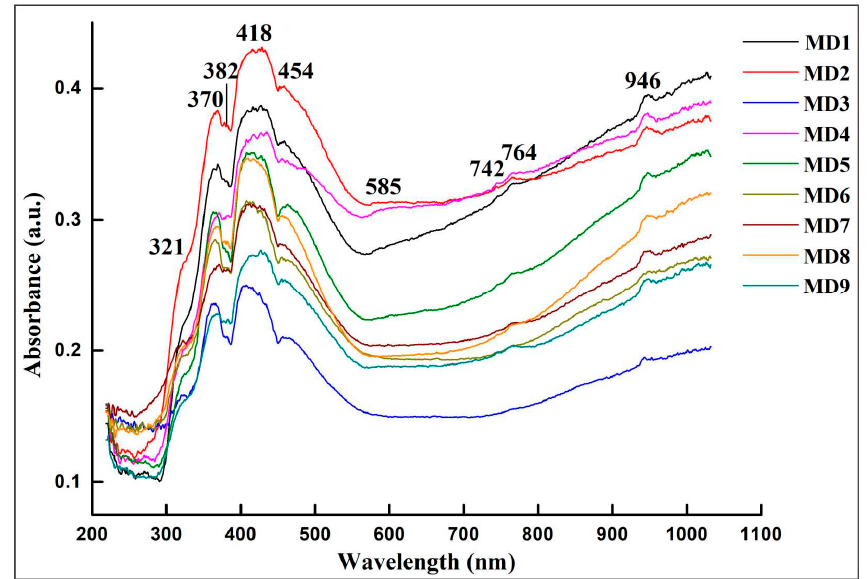
Figure 5. Representative UV-Vis-NIR spectra of sapphires. Table 2. UV-Vis absorption peak frequency and attributes of sapphires in this study and other locations (nm). (Table 2). The absorption peak caused by Fe 2+ -Fe 3+ charge transfer in the Sapphire Varieties